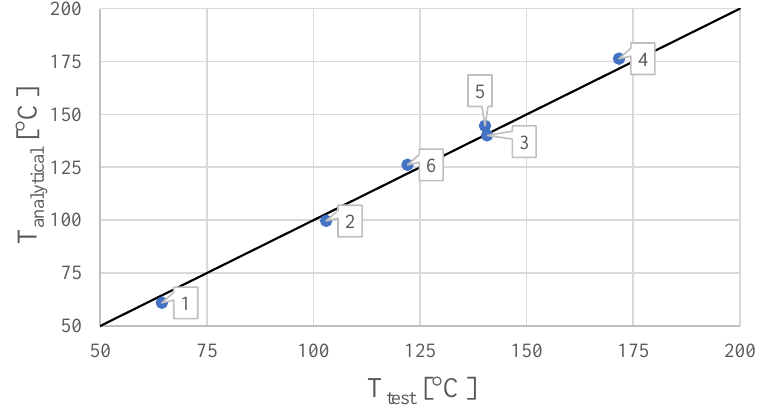
Figure 14. Comparison between the analytical model output T analytical and the corresponding experi- mental test temperature reading T test . The data labels indicate the test configuration,